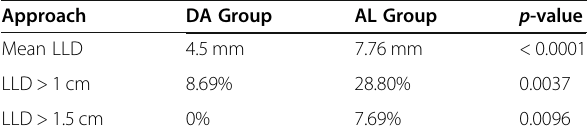
Table 2 Leg length discrepancy